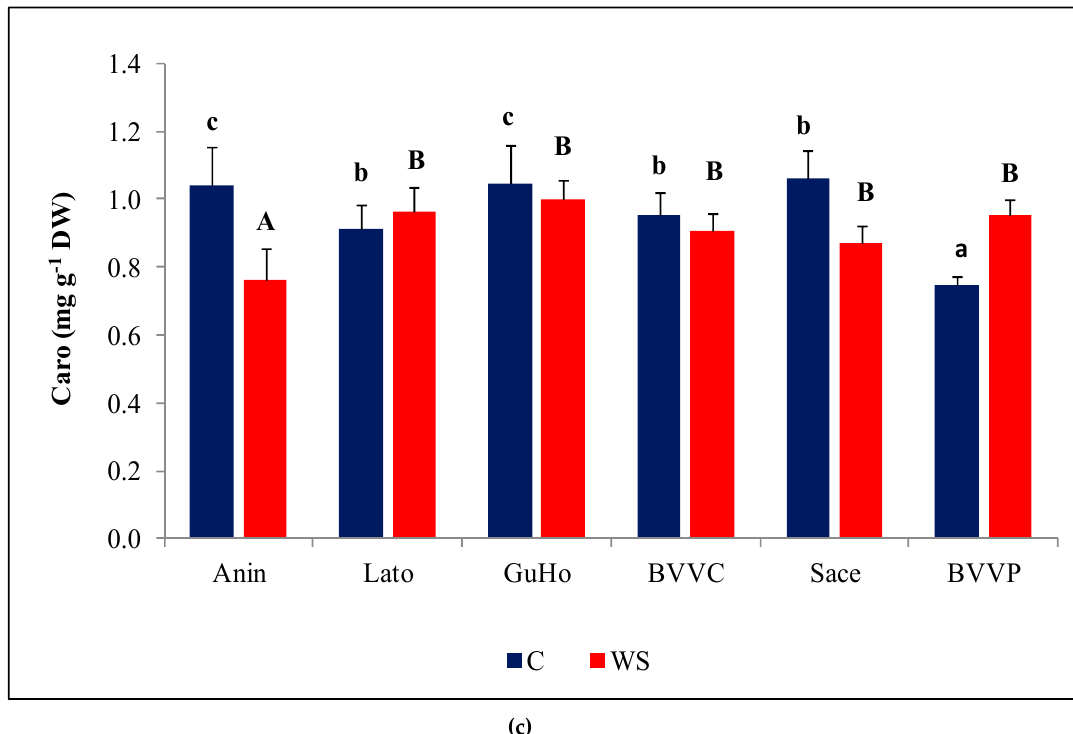
Figure 4. Photosynthetic pigments in the needles of six Romanian provenances of L. decidua after one month of applied drought stress (Mean ± SE, n = 5): ( a ) Chlorophyll a (Chl a) expressed in mg g − 1 DW; ( b ) Chlorophyll b (Chl b) expressed in mg g − 1 DW; ( c ) total carotenoids (Caro) expressed in mg g − 1 DW. Comparing provenances, different lowercase letters indicate significant differences between control plants, and different uppercase letters indicate significant differences between drought- affected plants, according to Tukey’s test ( α = 0.05). Asterisks indicate a significant difference between treatments within the same provenance, according to the LSD value for the interaction ( p = 0.05).